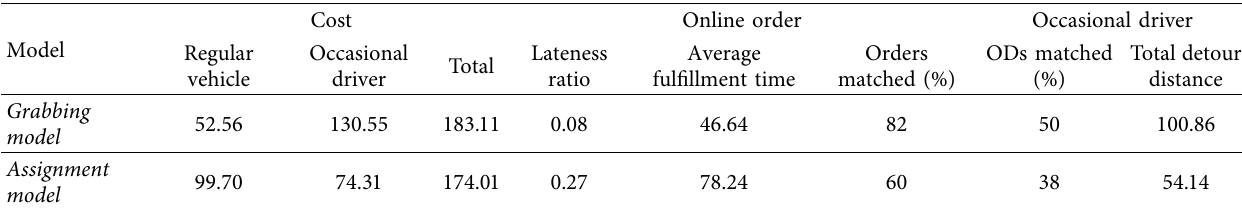
Table 3: Comparison of the grabbing and proposed assignment